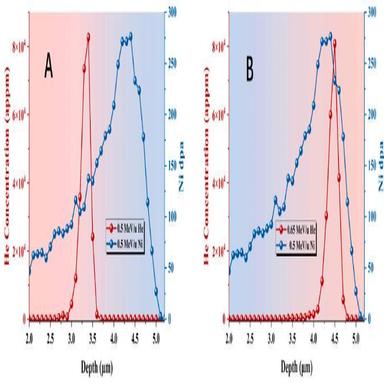
Contrast of deposition depths before (A) and after (B) energy adjustment.